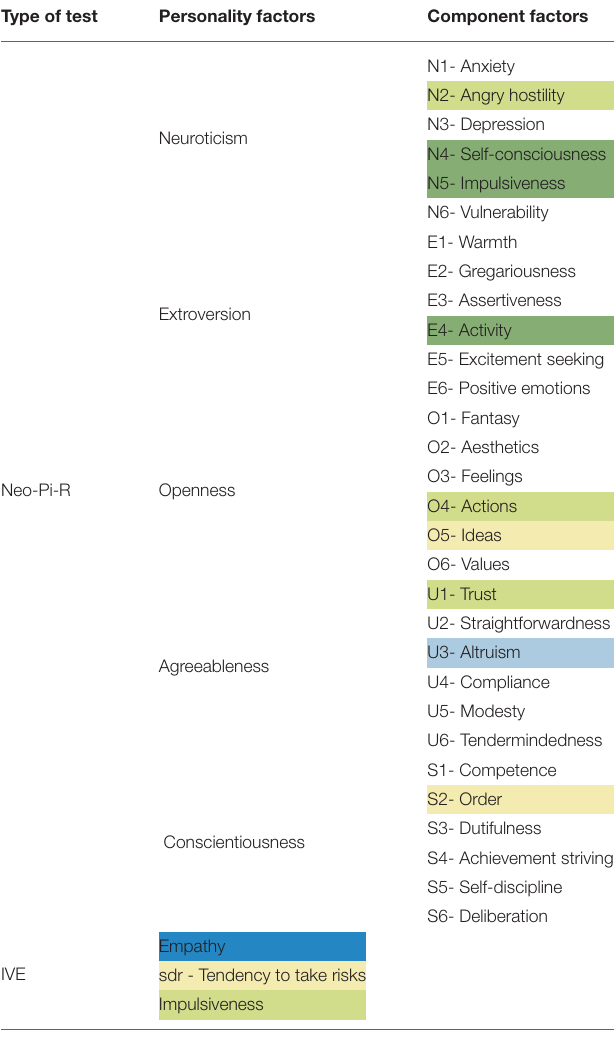
TABLE 11 | List of personality traits with the most important ones for attractiveness (marked light yellow—the positive impact on the dependent variable, dark yellow—the negative impact on the dependent variable), trust (marked light green—the positive impact on the dependent variable, dark green—the negative impact on the dependent variable) and attractiveness and trust at the same time (marked light blue—the positive impact on the dependent variables, dark blue—the negative impact on the dependent